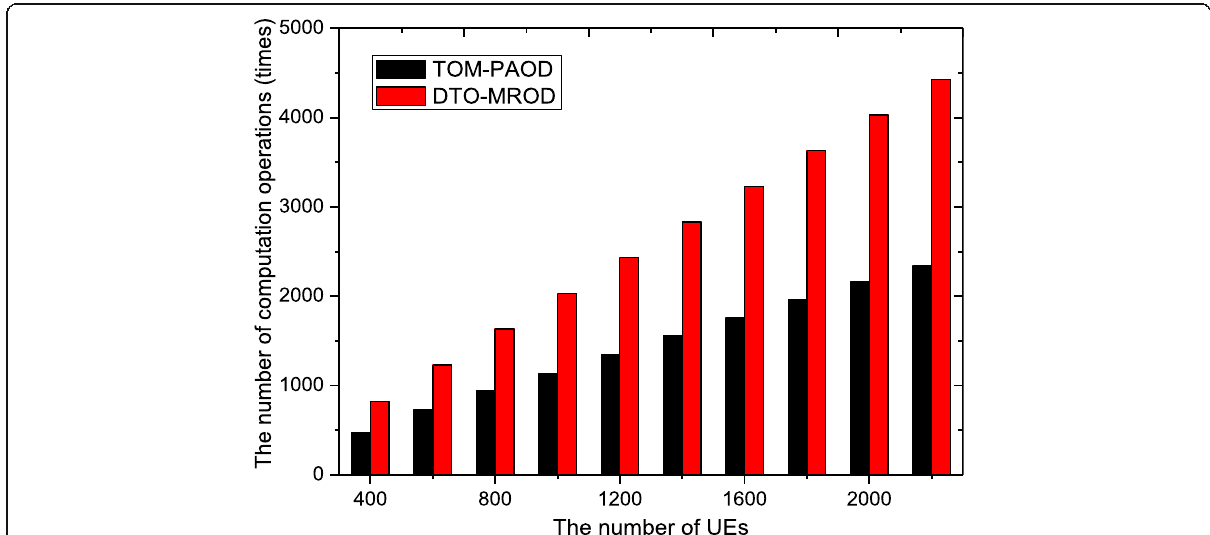
Fig. 7 Comparison of the number of computation operations: variation trend of the number of computation operations in the two schemes with the number of UEs in the given region